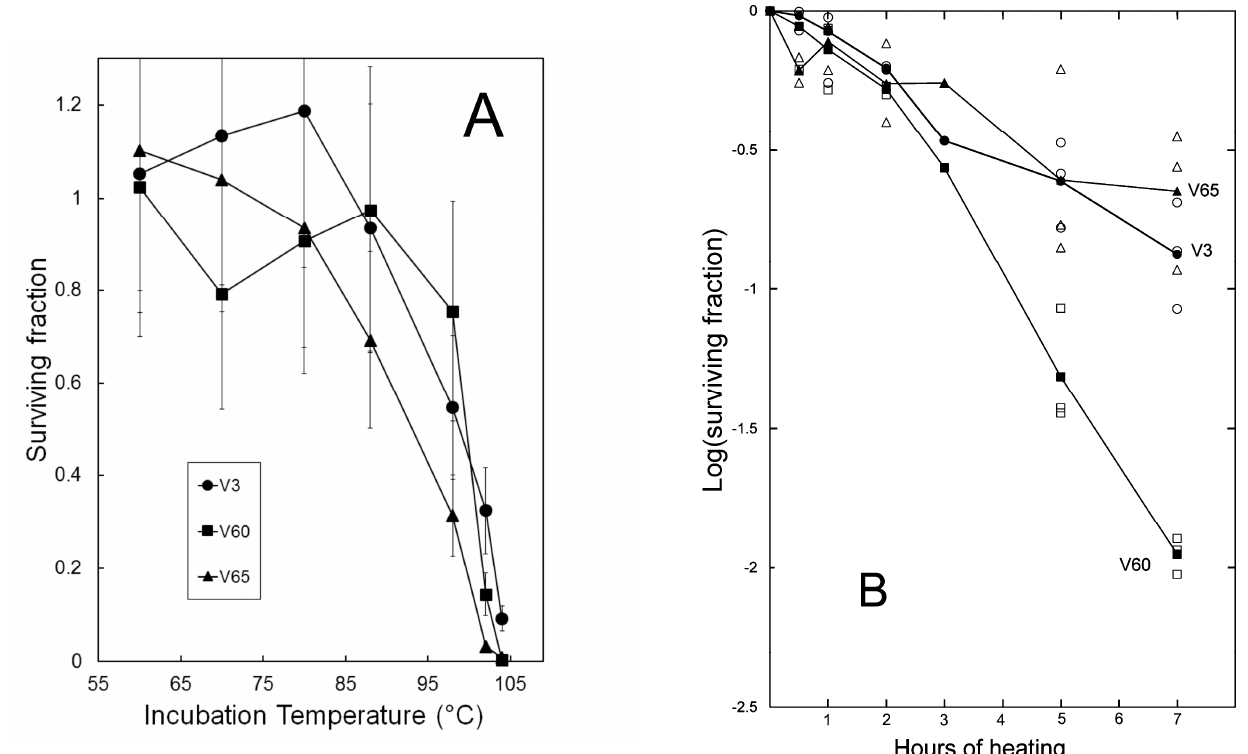
Figure 5. Thermal inactivation of virions. Lysates were diluted to titers of 10 4 –10 5 per mL in S dil buffer and exposed to the temperature indicated. Surviving PFU were enumerated by plaque assays. Panel ( A ): effects of one-hour incubation at the indicated temperatures (average of three determinations); panel ( B ): time course of infectivity loss in a boiling water bath (solid symbols indicate average of three independent trials).